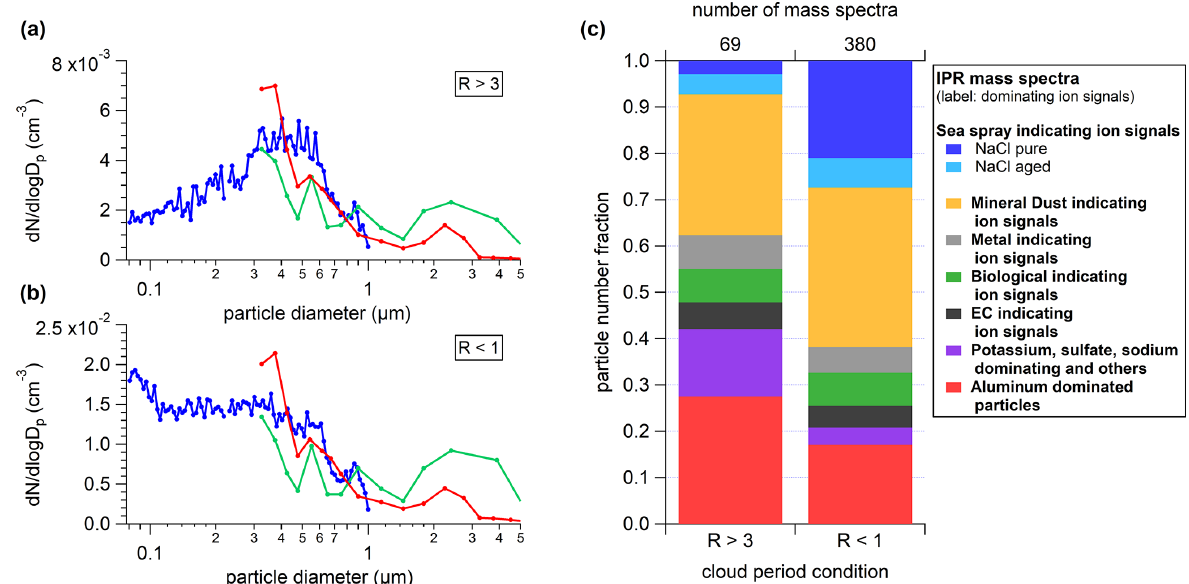
Figure 7. Comparison of duration-weighted mean IPR number size distribution of cloud periods with lower ( R > 3, a) and higher ( R < 1, b ) proportion of small IPRs ( < 300nm), and respective IPR composition (c) , which is interpreted as lower and higher contribution of secondary ice, respectively (see description in Sect. 3.5.1). Details about the individual cloud periods are presented in Tables S3 and S4. The size distributions are shown in (a) and (b) and were measured using a UHSAS (blue), an OPS (green), and a Sky-OPC (red). The IPR composition shown in (c) was determined with the ALABAMA.